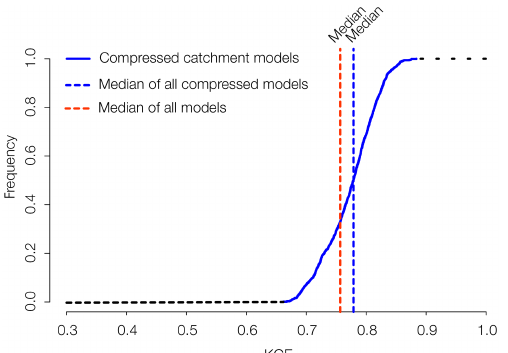
Figure 6. Distribution of model performances of the different real- izations of the compressed catchment model (blue). The two dashed lines correspond to the median of the KGE values of all realization of the compressed catchment model (blue) as well as to the area- weighted median of all 105 hillslope models